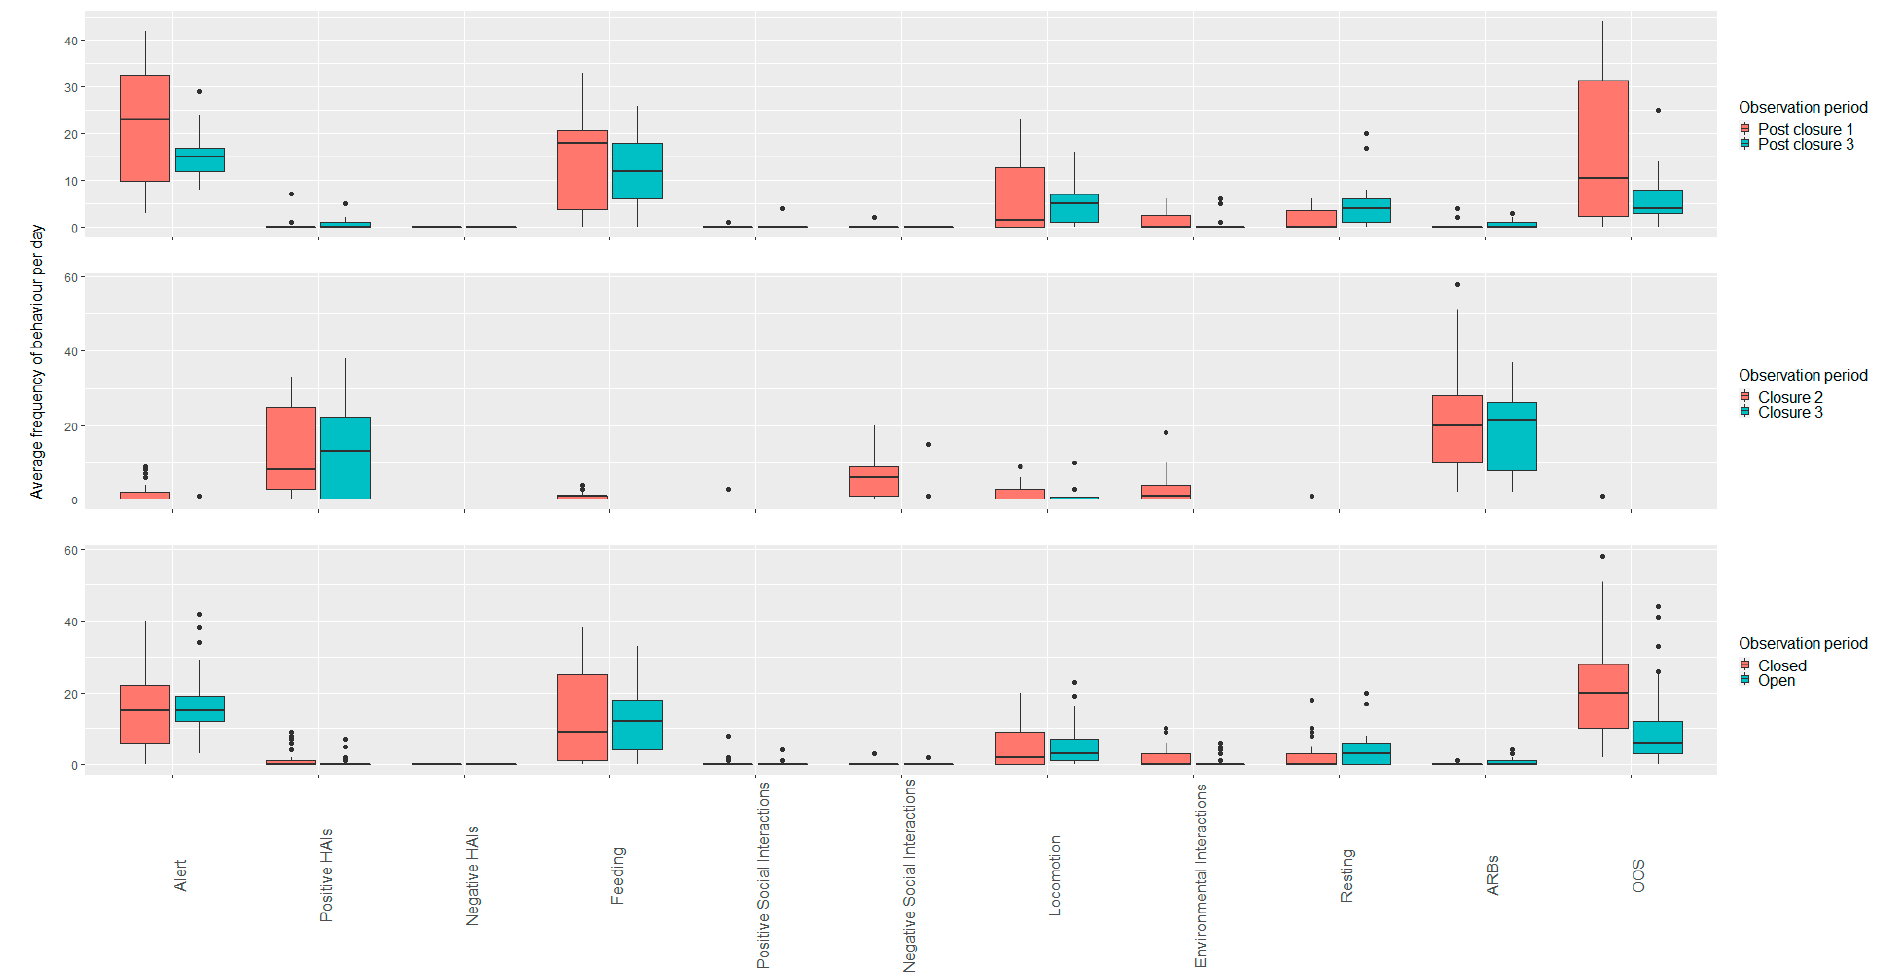
Figure 6. An overview of activity throughout the closure and reopening periods for meerkats housed at White Post Farm. Dots represent outliers.